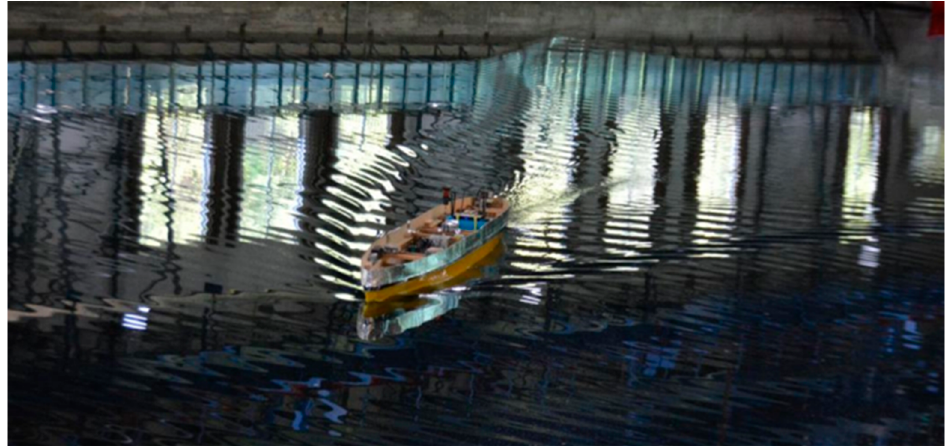
Figure 6. Picture of model during test campaign.